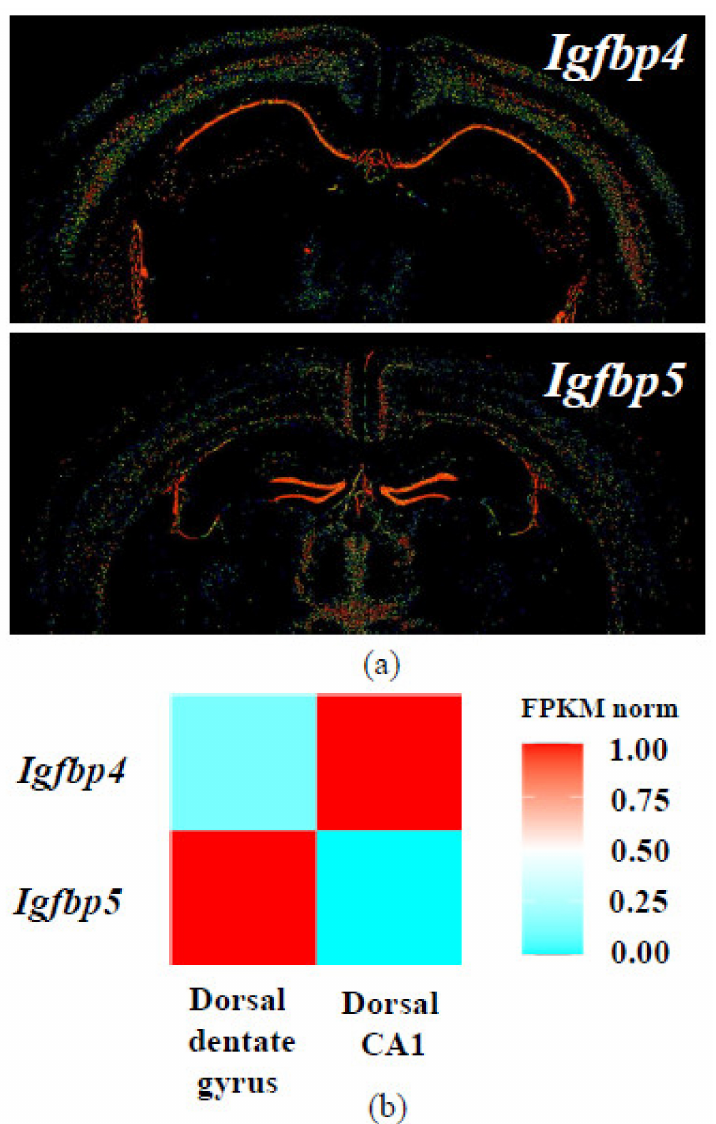
Figure 7. Expression patterns of Igfbp4 and Igfbp5 mRNA in the mouse brain according to databases. ( a ) In situ hybridization results from Allen Mouse Brain Atlas [144–146]; ( b ) Normalized Igfbp4 and Igfbp5 expression heatmap for dorsal CA1 and dentate gyrus hippocampal principal neurons from Hippocampus RNA-seq atlas